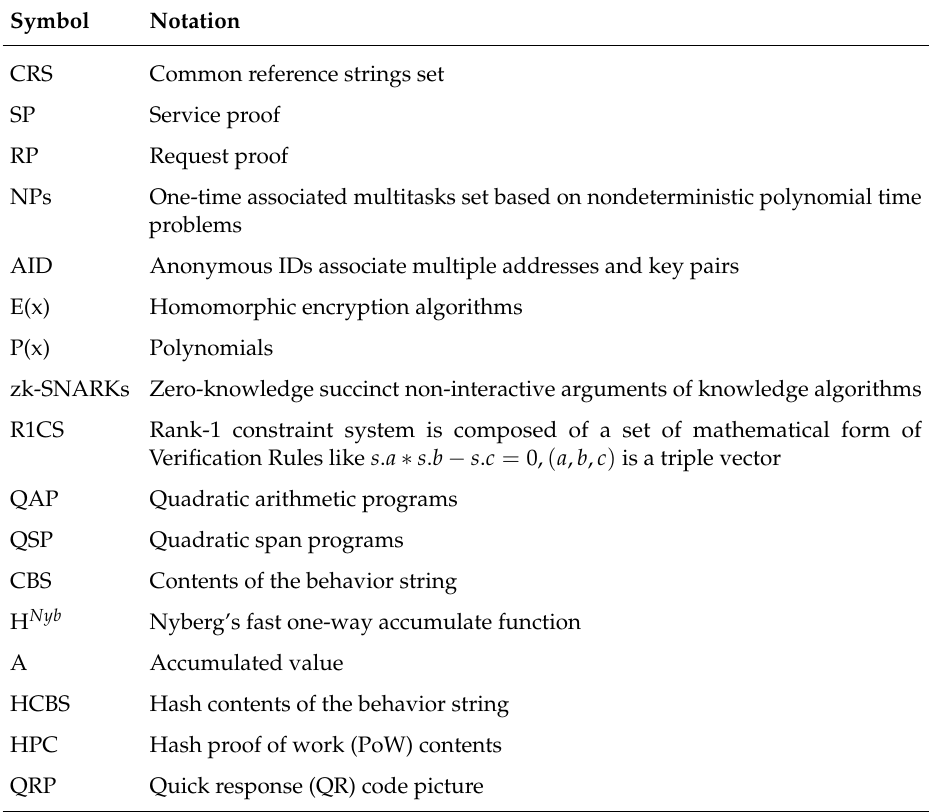
Table 1. Notation in the OTMP-P2L